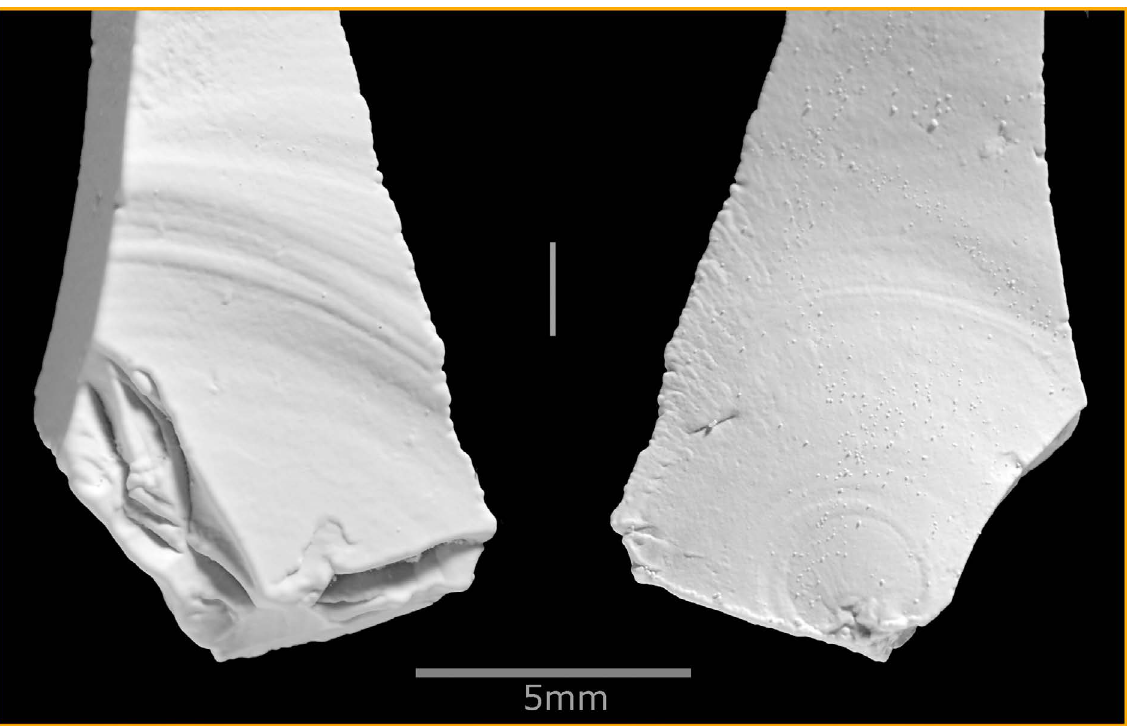
Figura 9. Lapa dos Coelhos, camada 3: lamela com rugas finas concêntricas partindo do ponto de impacto evidenciadas por pulverização com óxido de magnésio (Fotos de J. P. Ruas). Figure 9. Lapa dos Coelhos, layer 3: bladelet presenting concentric wrinkles starting from the impact point evidenced by covering with magnesium oxide (Photo by J. P.